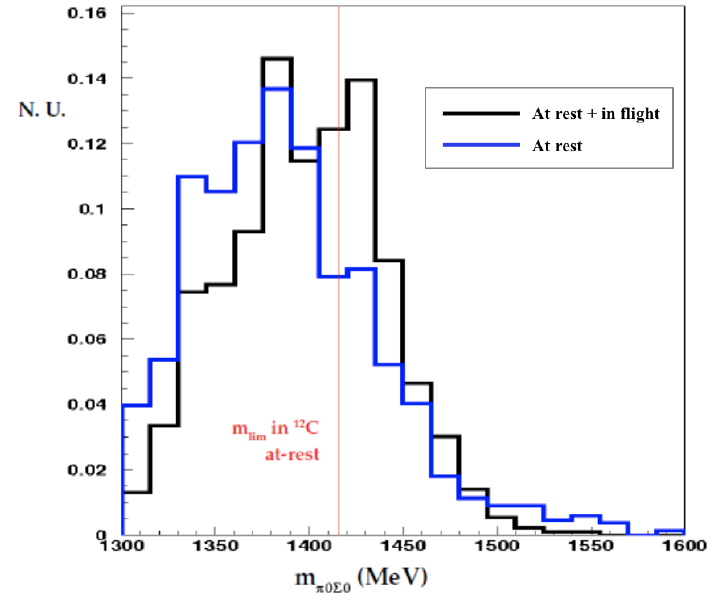
Figure 1. (Colour online.) m Σ 0 π 0 invariant mass distribution from K − captures in the KLOE DC wall (black curve) and pure carbon graphite target (blue